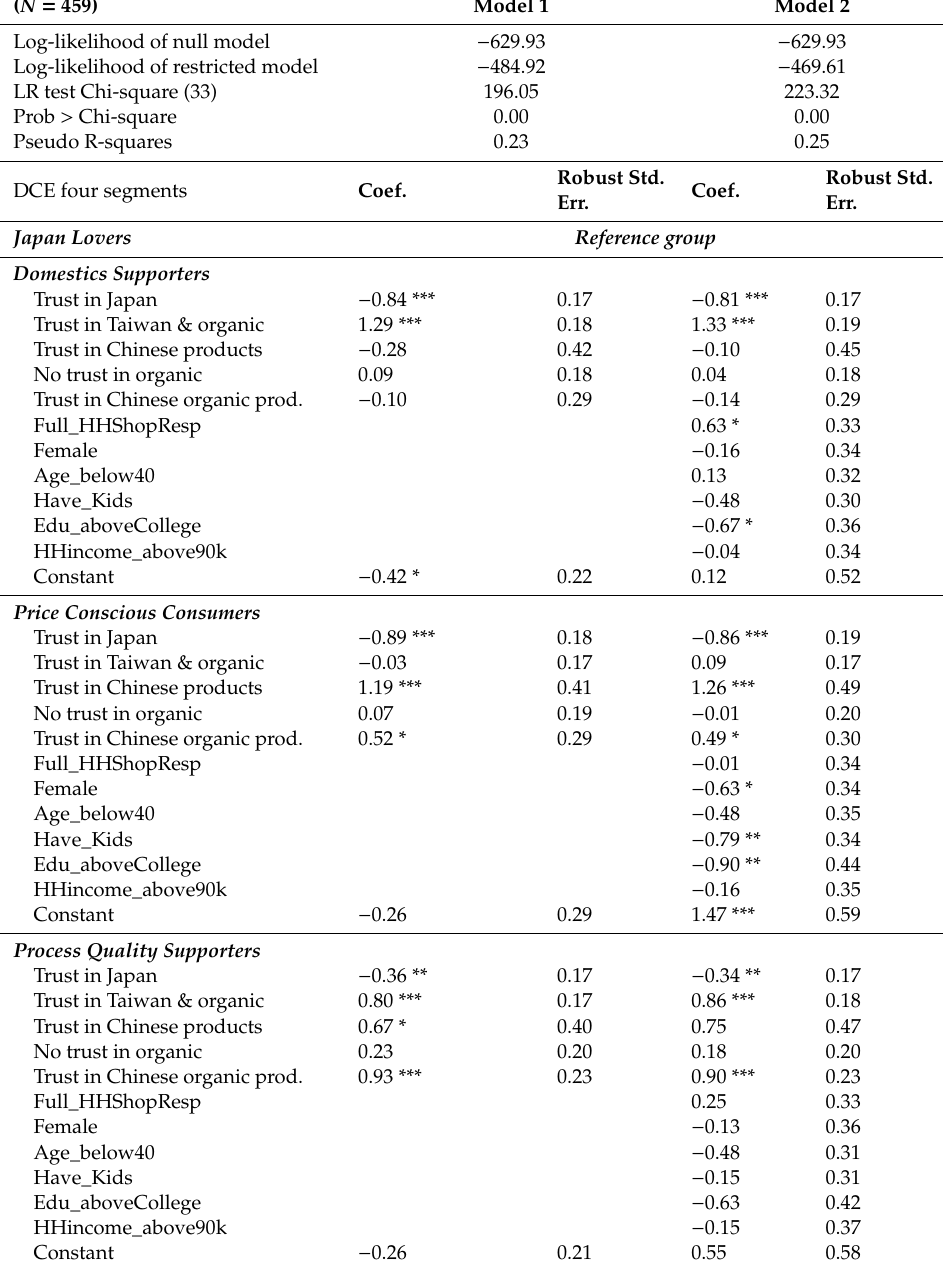
Table 10. Multinomial logit models: DCE latent class membership regressed on five trust components (Model 1) and on five trust components plus sociodemographics (Model